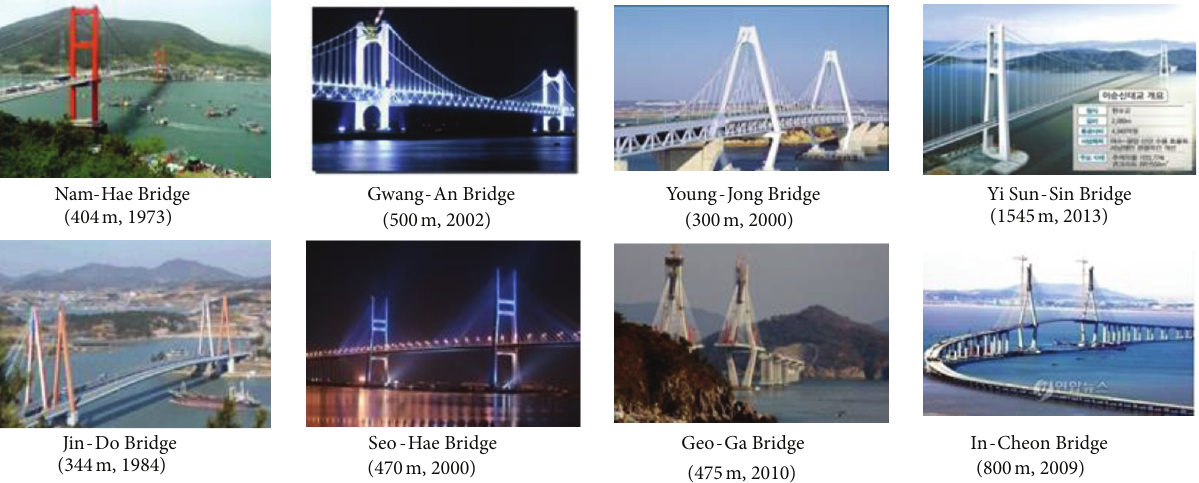
Figure 2: Cable-supported bridges in Korea. Numbers in parenthesis show the main span length and constructed